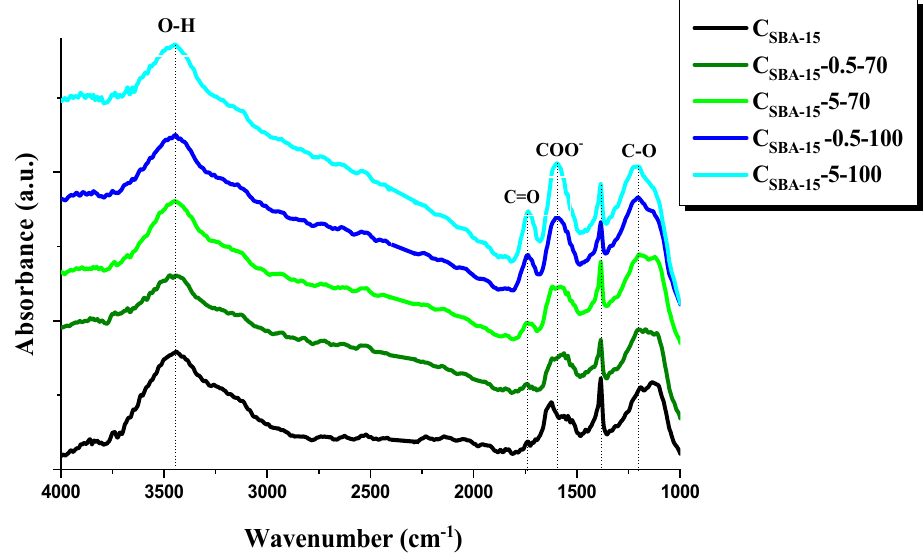
Figure 2. FT-IR spectra of carbon adsorbents obtained.